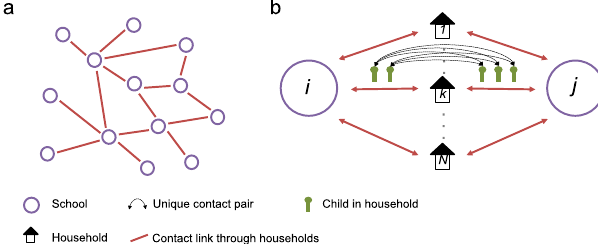
Fig. 6 Schematic to demonstrate the principle of a network of schools